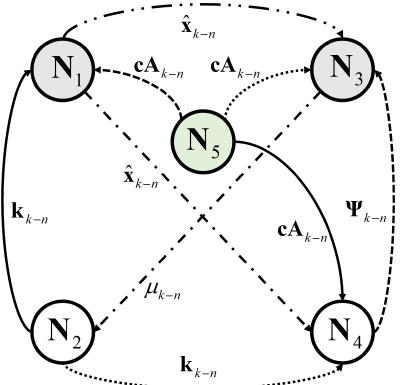
Figure 3. Working procedure for the transmission of